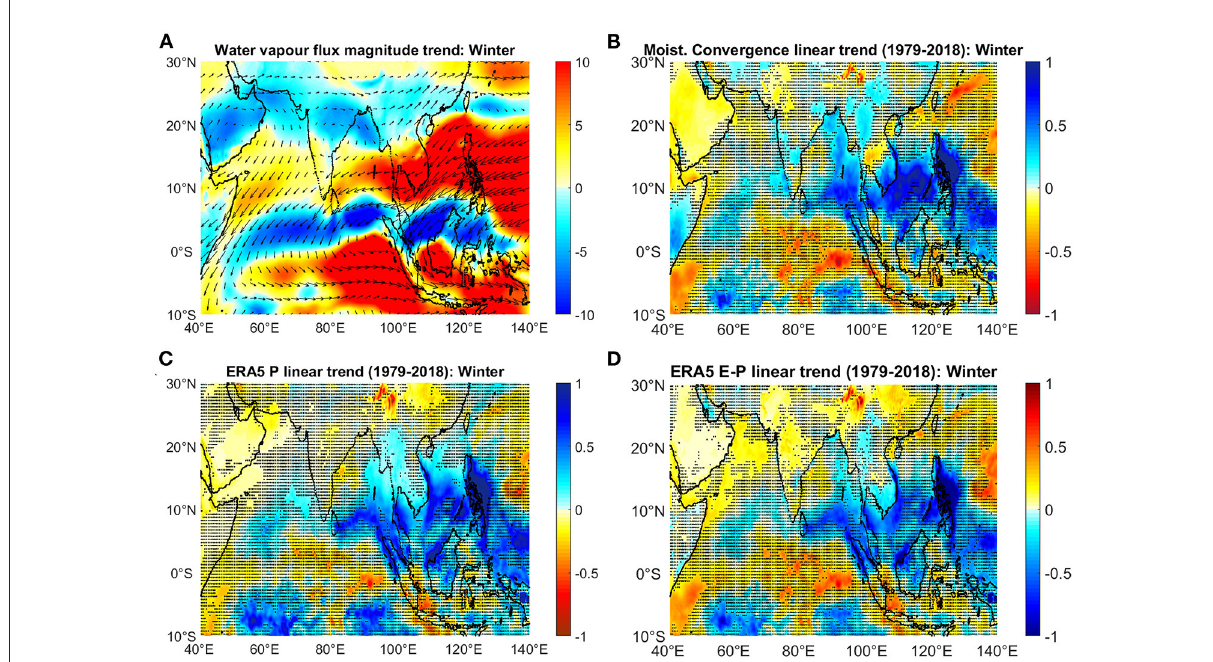
FIGURE10 ERA5 winter (DJF) linear trends (1979–2018) in (A) Magnitude of vertically integrated atmospheric water vapor transport (kg m − 1 s − 1 /dec.). The climatological winter mean atmospheric water vapor transport (vectors, kg m − 1 s − 1 ) is also depicted. (B) Moisture transport convergence (mm/day/dec.); (C) Precipitation (mm/day/dec.); (D) Evaporation minus Precipitation (mm/day/dec.). Regions where the linear trend is not significant at the 95% confidence interval are